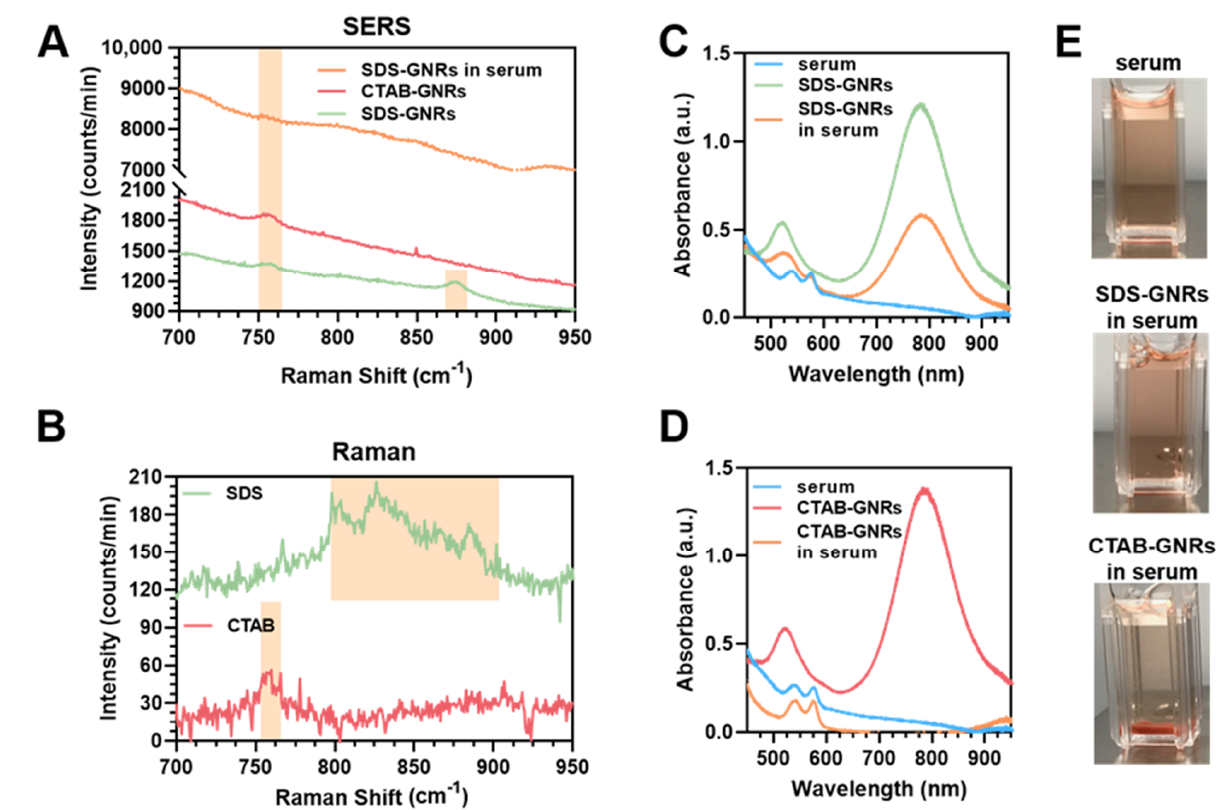
Figure 2. ( A ) SERS spectra of CTAB-GNRs and SDS-GNRs and tentative band assignments. ( B ) Unenhanced Raman spectra of pure CTAB and SDS solutions for reference. Absorption spectra of ( C ) SDS-GNRs and SDS-GNRs in serum and ( D ) CTAB-GNRs and CTAB-GNRs in serum. ( E ) Optical photos of the functionalized GNRs in serum showing instability of CTAB-GNRs.